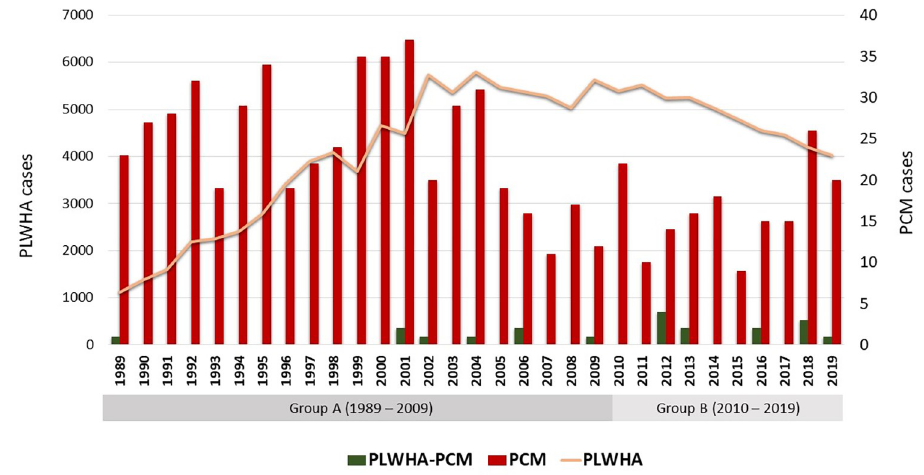
Fig 1. Annual cases of people living with HIV/AIDS at Rio de Janeiro State, PCM at INI/FIOCRUZ, and association of PCM and HIV/AIDS at INI/FIOCRUZ between 1989 and 2019. PLWHA: People living with HIV/ AIDS; PCM: Paracoccidioidomycosis. Source: DATASUS and SIPEC-FIOCRUZ.